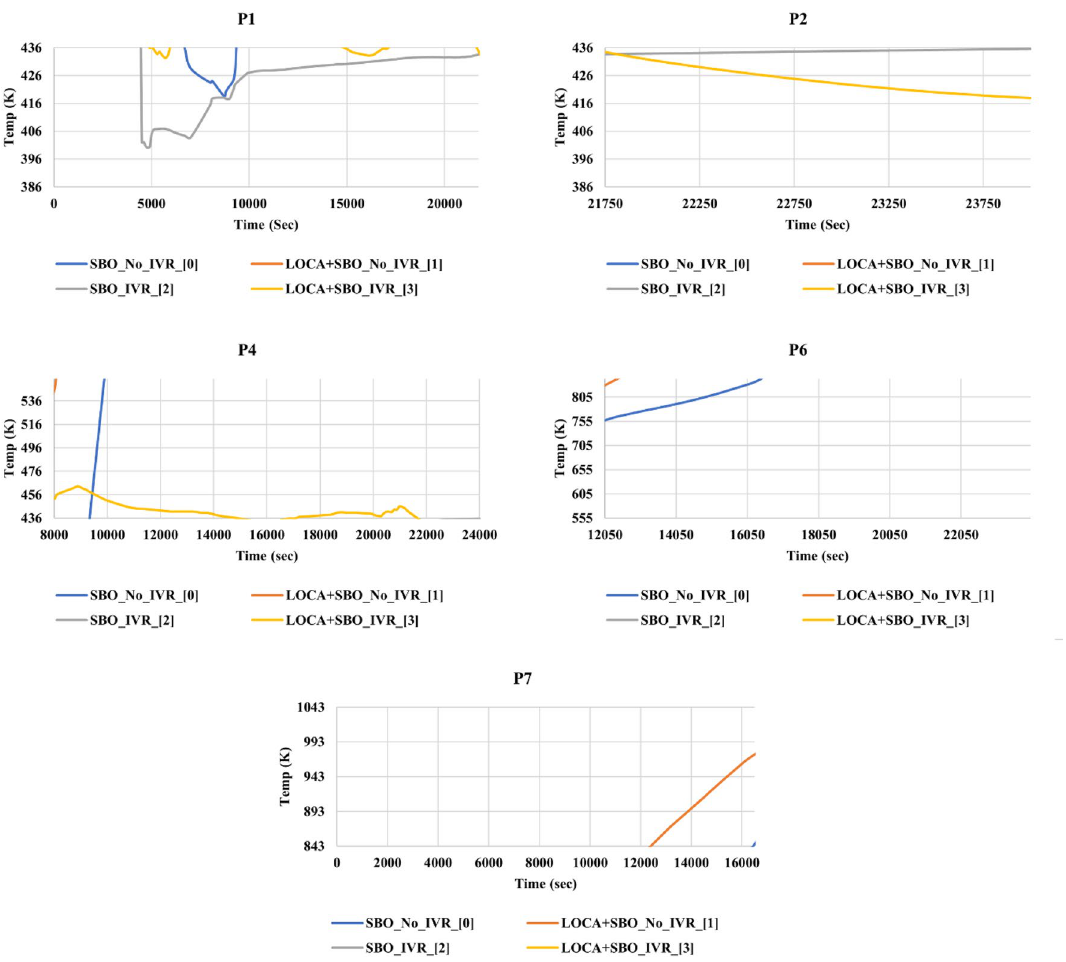
Figure 4. Applying thresholds of each path to the time-wise accident progression